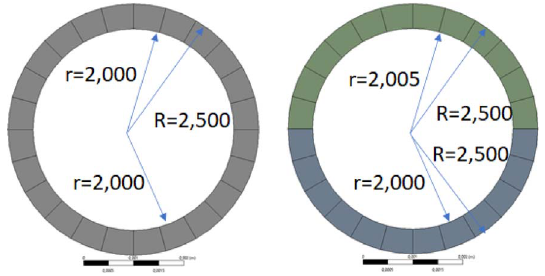
Figure 18. De fl ection at the end point of the asymmetric tube excited by unitary internal pressure and point receptance excited by unitary force at the end of tube.